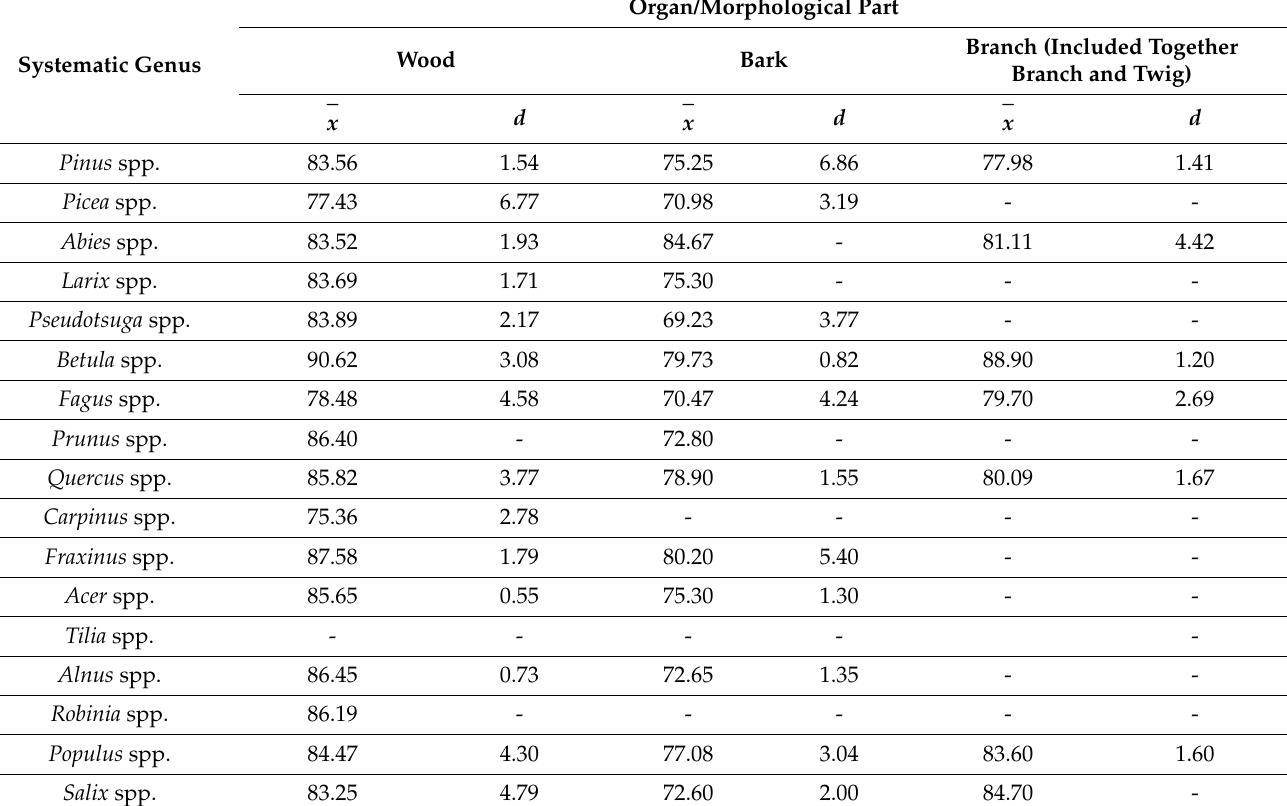
Table A14. Average value and average deviation of the volatile matter content (% d.m.) in various organs of particular systematic genera